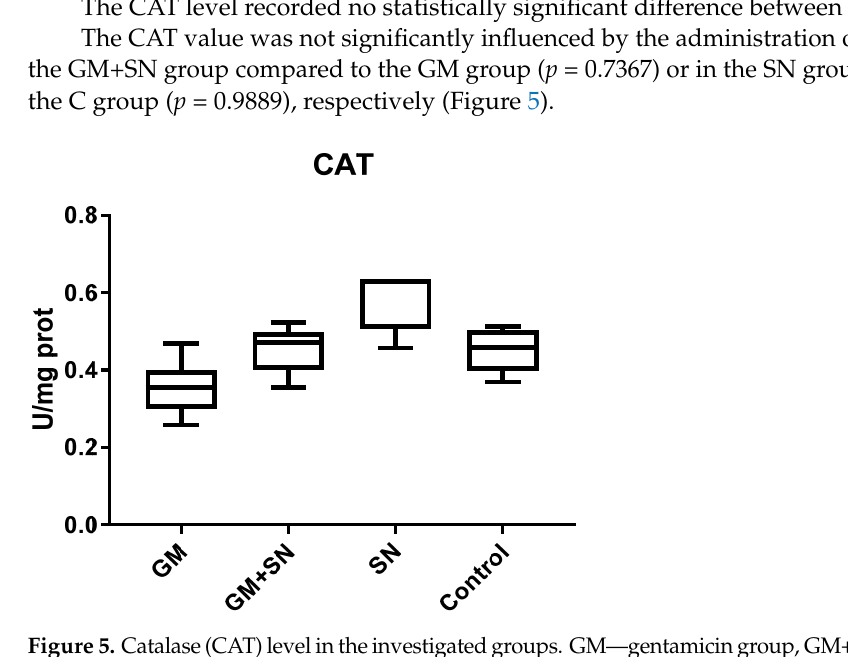
Figure 4. Superoxide dismutase (SOD) level in the investigated groups (** p < 0.01, **** p < 0.000). GM—gentamicin group, GM+SN—gentamicin and Sambucus nigra group, SN— Sambucus nigra group, Control—control group (no treatment).